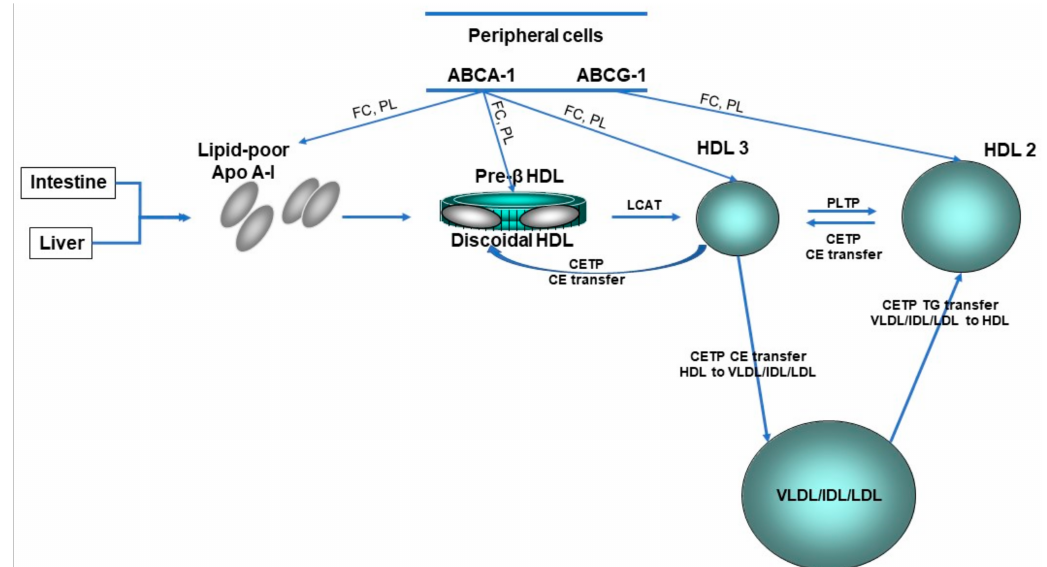
Figure 2. HDL lifecycle. The liver and gut synthesize apolipoprotein (Apo) A-I which become discoid nascent HDL after interaction with the ATP-binding cassette transporter A-1 (ABCA-1). Pre- β HDL is converted by lipidation with free cholesterol (FC) and phospholipids (PL) via ABCA-1 and ABCG-1 and cholesterol esterification via lecithin:cholesterol acyltranferase (LCAT) to spherical HDL3. HDL3 is converted to HDL2 by the fusion of small HDL particles activated by phospholipid transfer protein (PLTP). CE, cholesteryl ester; CETP, cholesteryl ester transfer protein; HDL, high-density lipoprotein; IDL, intermediate-density lipoprotein; LDL, low-density lipoprotein; TG, triglyceride; VLDL, very low- density